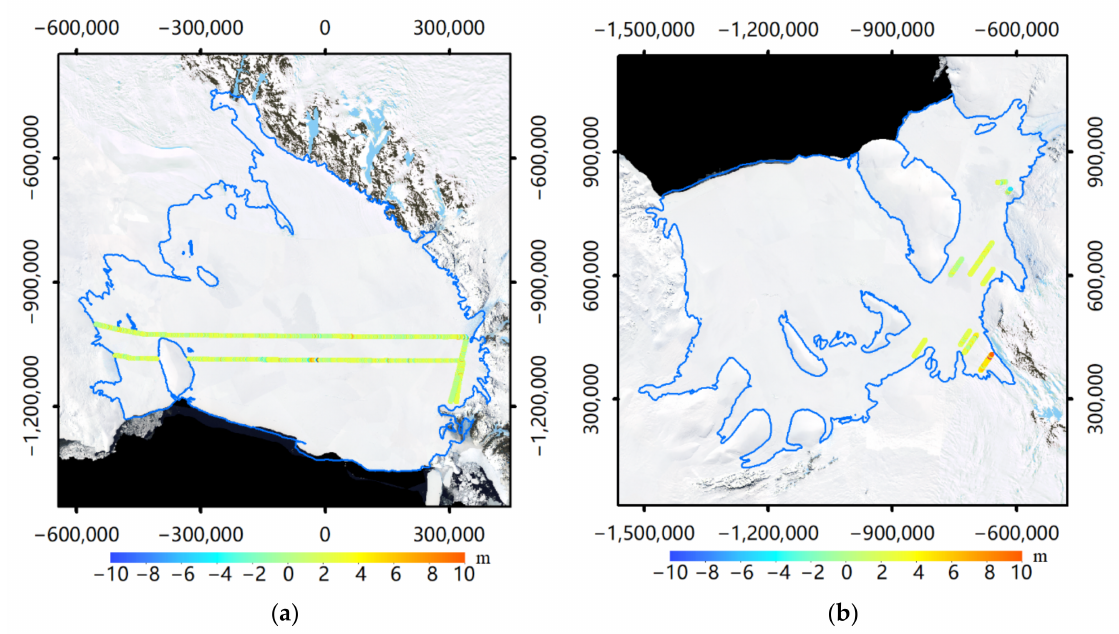
Figure 9. The distribution map of difference between ICESat-2 RIS DEM ( a ) as well as FRIS DEM ( b ) and Operation IceBridge (OIB) elevations. Maps are in the polar stereographic projection in